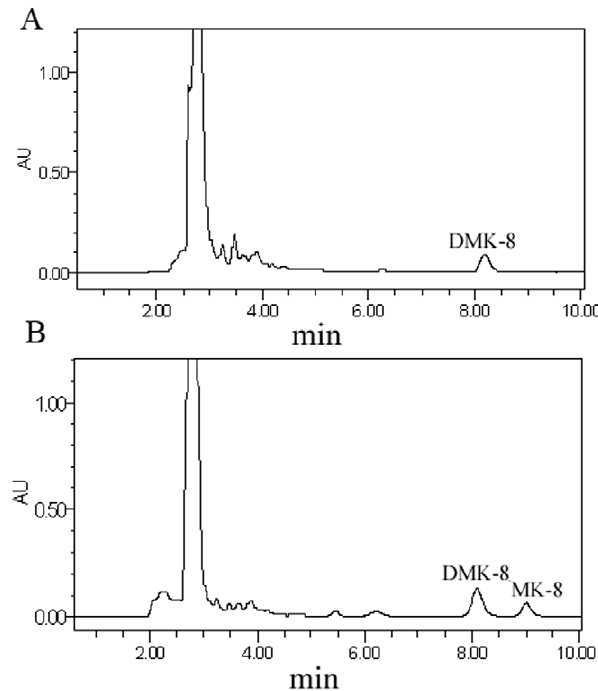
Figure 8. HPLC analyses of quinone compounds for testing DmtH peotein activity. (A) DMK-8 was extracted from E.coli JC7623 D 4-1( ubiE : Kan r ) but MK-8 was not formed; (B) MK-8 was synthesized in vitro in the reaction system by purified DmtH protein, SAM and E.coli JC7623 D 4-1 cell homogenate at 37 u C for 1 h.